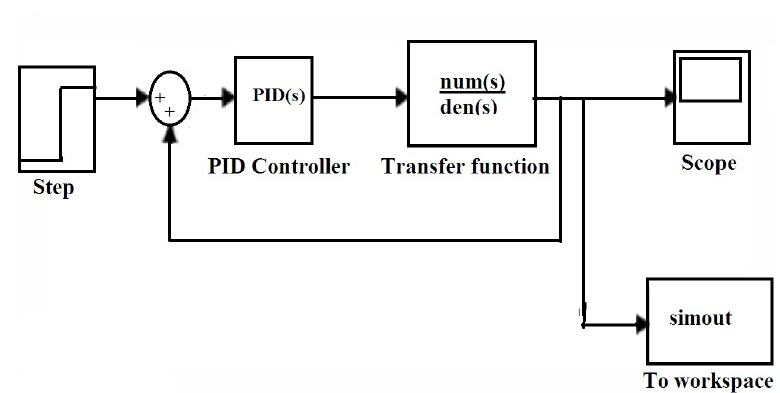
Figure 12. SIMULINK Model for Drug Delivery System with Controller.